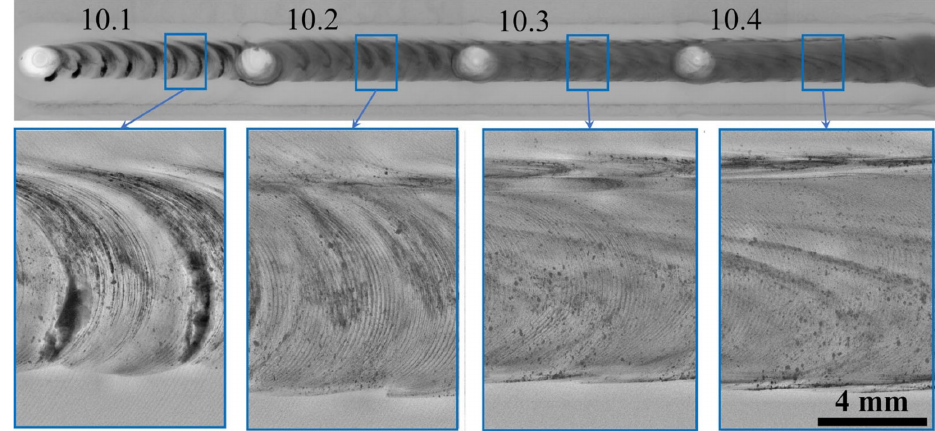
Figure 5. CT images of the processed area of Al-Mg-Sc alloy with 10 wt% Mo.